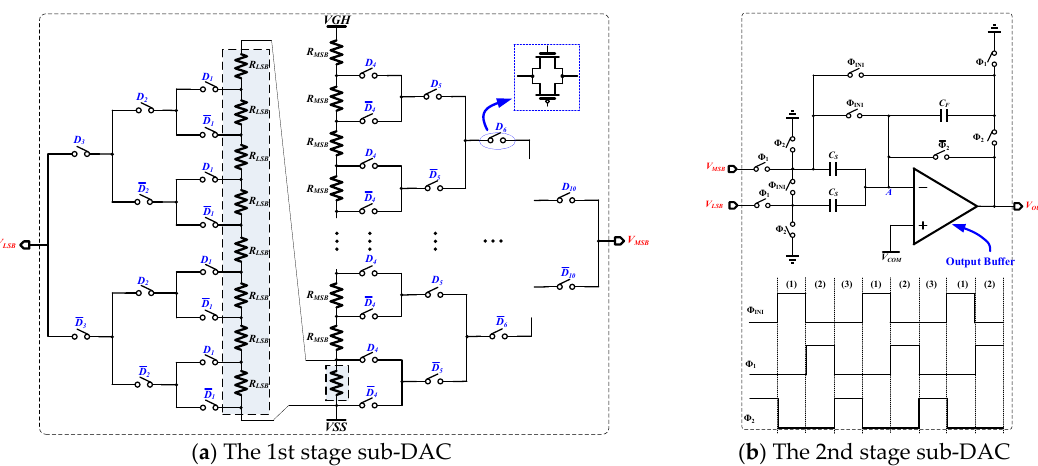
( b ) The 2nd stage sub-DAC